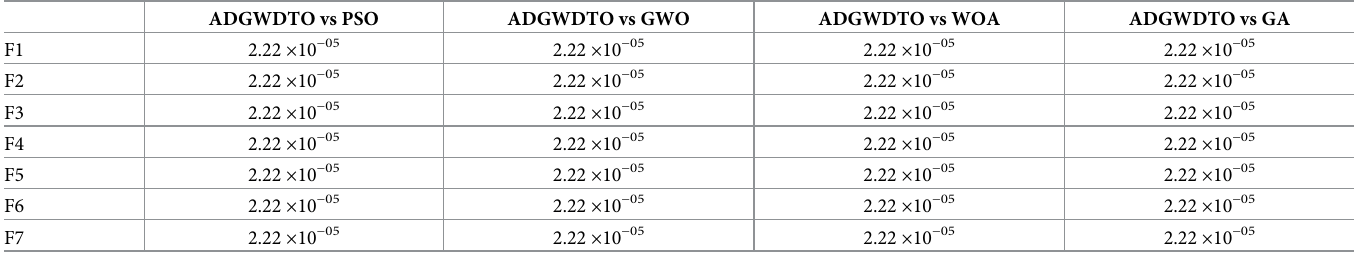
recommended and compared benchmark function algorithms (F1 to F7). The outcomes of the ANOVA test for the reference functions are shown in Table 13. The T-test for the benchmark functions (F1 through F7) using the recommended algorithm versus the compared techniques is presented in Table 14. The results illustrate the efficacy of the proposed methodology. Table 14. Benchmark functions T-test for the proposed and compared